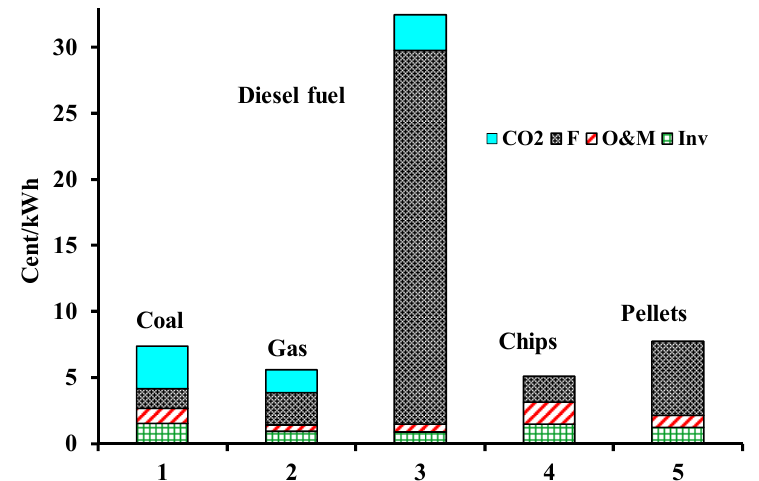
Figure 4. Energy cost components in absolute units (Inv is investment, O&M is operation and maintenance, F is fuel, CO 2 associated with the payment for carbon dioxide emissions).